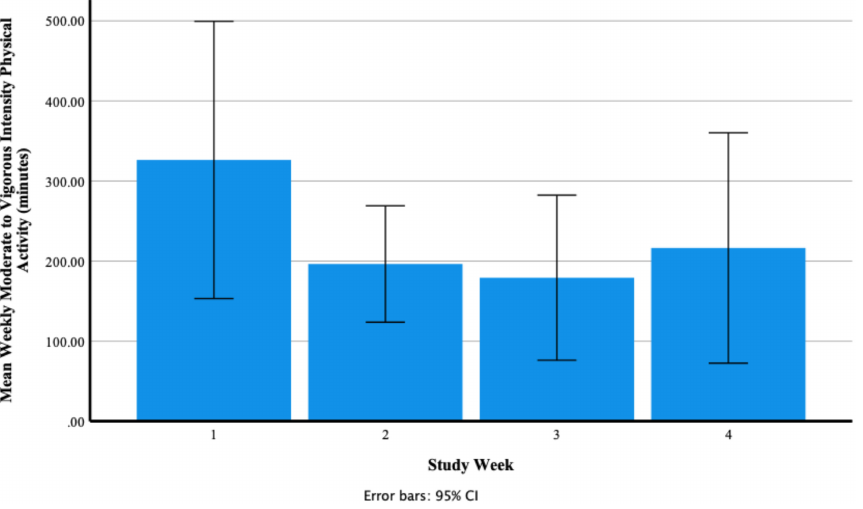
Figure 8. Participants’ mean weekly moderate- to vigorous-intensity physical activity (minutes) as recorded via the Fitbit Charge 4 activity tracker.